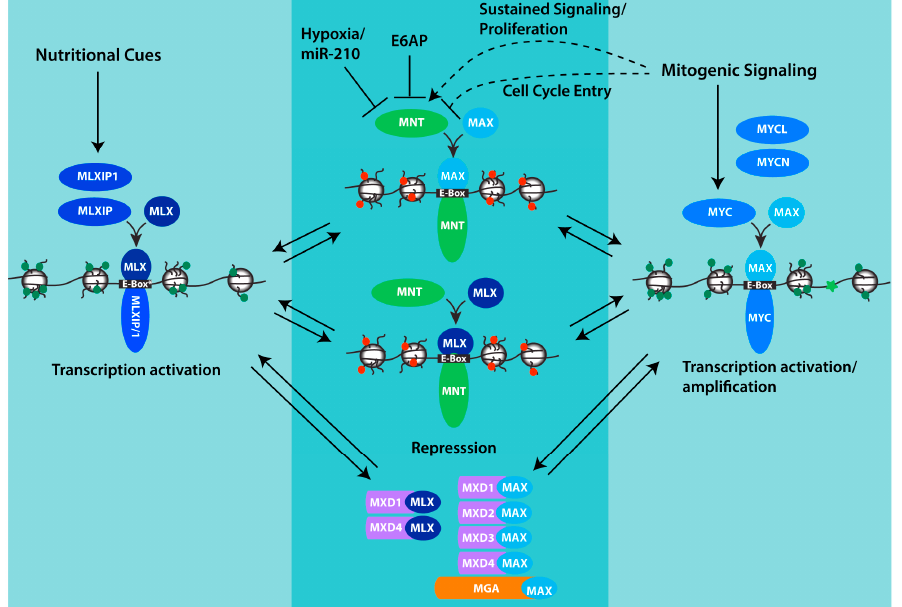
Figure 1. MNT and its place in the MAX-MLX network of interacting proteins. Through its interaction with both MAX and MLX, MNT is positioned to compete with both MLXIP/MLXIP1 and MYC family proteins for interaction with MLX and MAX respectively, and for binding to shared target genes. Whereas MYC and MLXIP complexes promote transcription, MNT complexes repress transcription. Chromatin is depicted to indicate histone modifications and architecture that acts to promote transcription (green marks, relaxed conformation, MYC-MAX and MXLIP/1-MLX) or repress transcription (red marks, closed conformation, MNT-MAX, MNT-MLX). MXD-MAX, MXD-MLX and MGA-MAX complexes also repress transcription and may function in concert with MNT complexes to antagonize transcription by MYC and MLXIP complexes and fine-tune the expression of shared target genes. For MNT, its abundance can be downregulated by hypoxia and specifically through the inhibitory mRNA binding by miR-210 which is strongly induced by hypoxia. MNT can also be downregulated by the ubiquitin ligase E6AP. The effect of mitogenic signaling on MNT appears variable, with evidence that MNT is significantly increased in settings of sustained proliferation, but that in the setting of growth-factor-induced cell cycle entry, phosphorylation of MNT by ERK acting downstream in the MAPK pathway transiently interferes with MNT binding to SIN3 corepressors and its ability to antagonize transcription by MYC. See text for additional details.